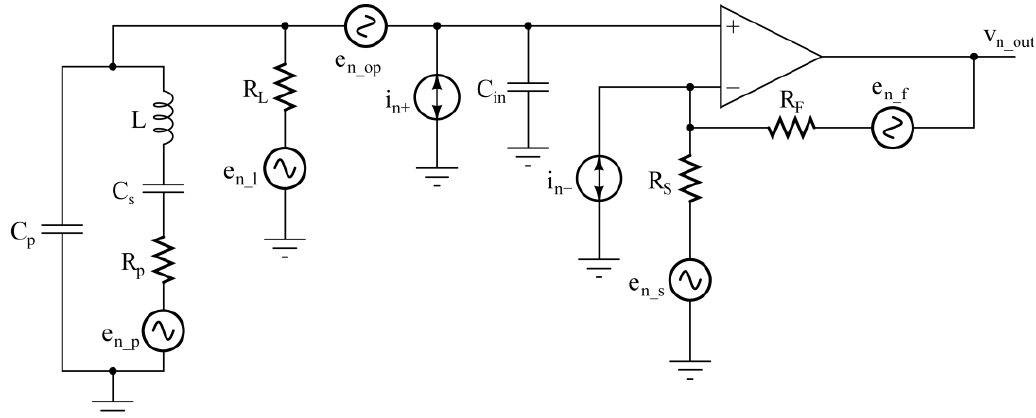
Figure 8. Noise contributions in the circuit of Figure 3 .